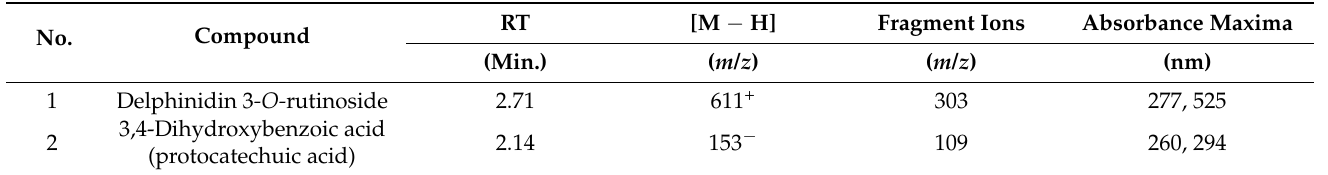
Table 3. UPLC-PDA-MS/MS properties of delphinidin 3 -O- rutinoside and protocatechuic acid as its major detectable metabolite (condition as in p.